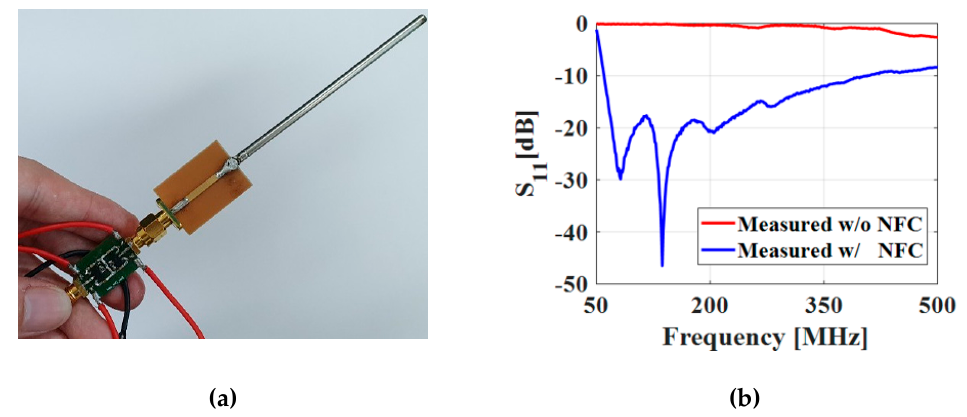
Figure 8. The measurement of the reflection coefficient of the monopole and non-Foster circuit assembly: ( a ) A picture of the fabricated non-Foster circuit connected to the monopole. ( b ) The measured reflection coefficient with and without the non-Foster circuit.